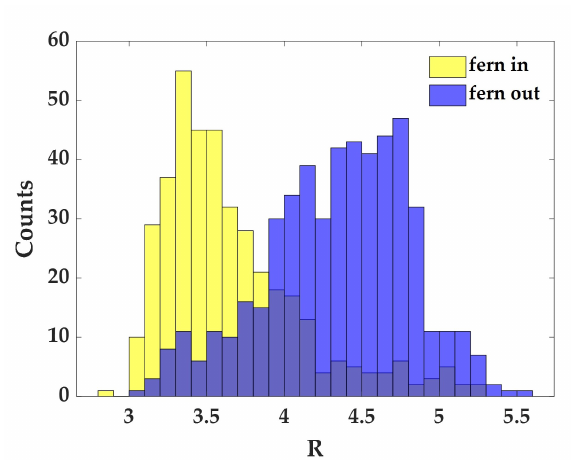
Figure 6. Distribution of the ratio R calculated for the spectra relative to yellow and blue region of the corresponding mask (Figure 4B).